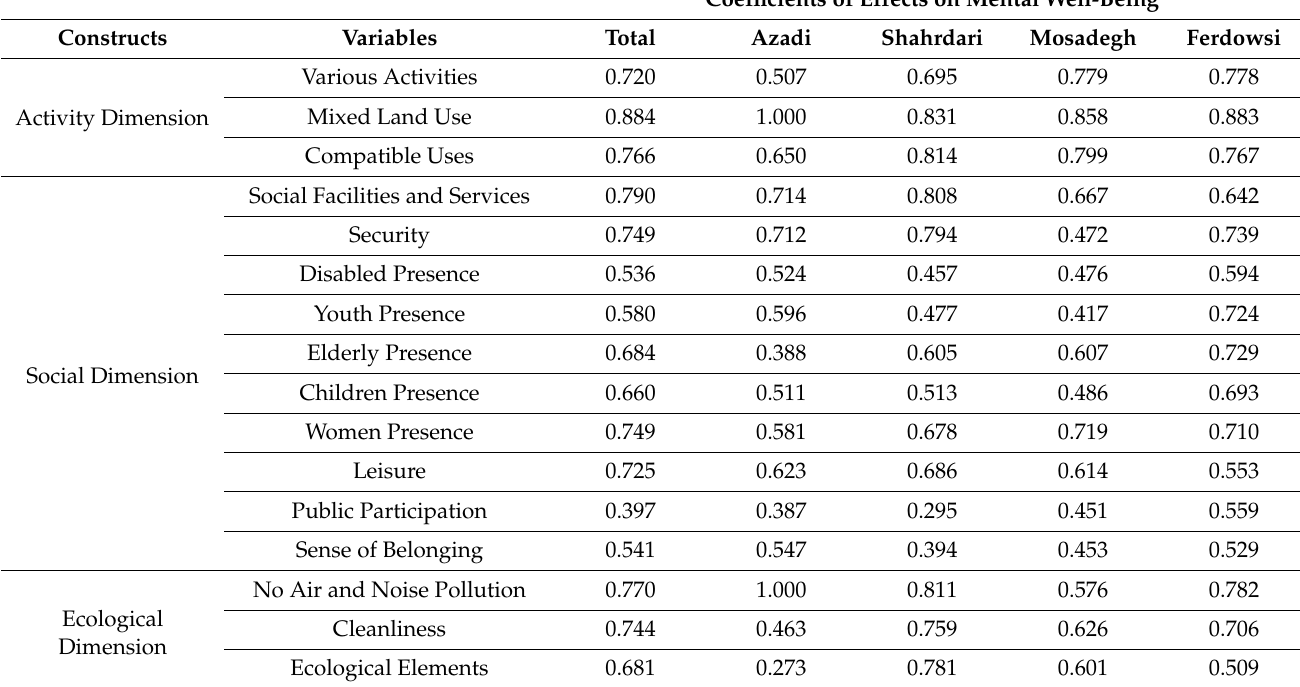
Table 9. The effects of environmental quality characteristics for each public open space on mental well-